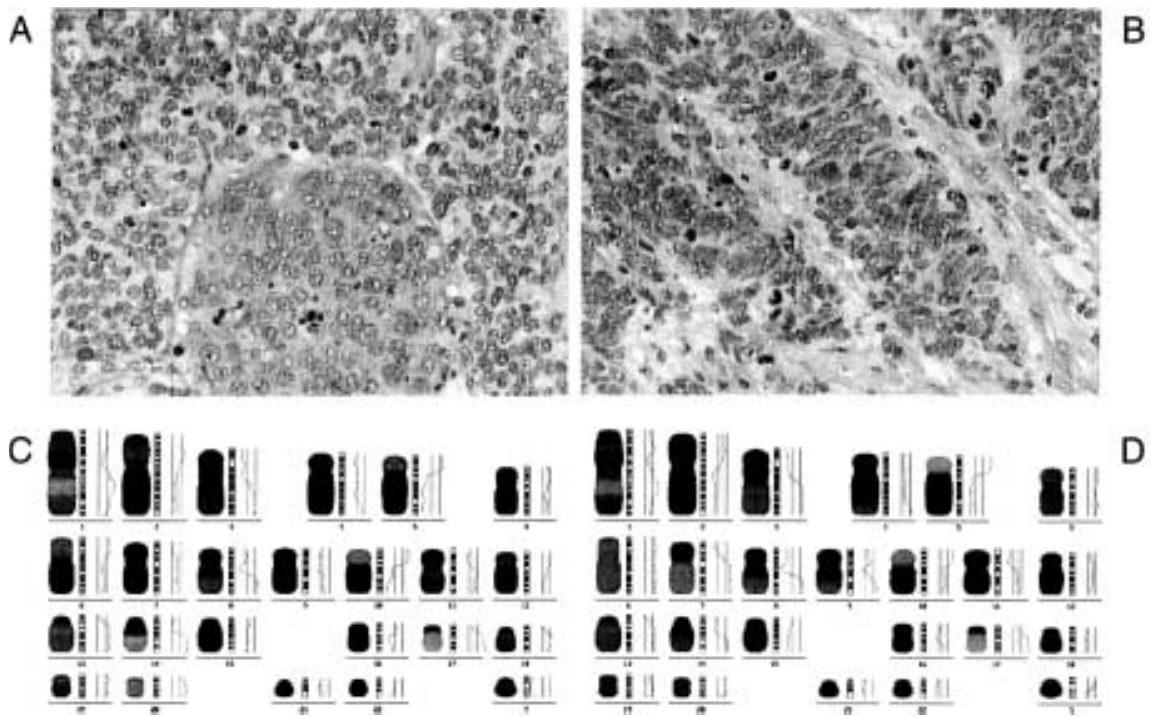
Fig. 2. H&E stains of the primary combined SCLC showing of a SCC component (A) and a synchronous metastasis exclusively with the SCLC phenotype (B). After microdissection the SCC component of the primary tumour (C) and the SCLC metastasis (D) was analysed by CGH showing a clonal relationship as evidenced by the high number of common